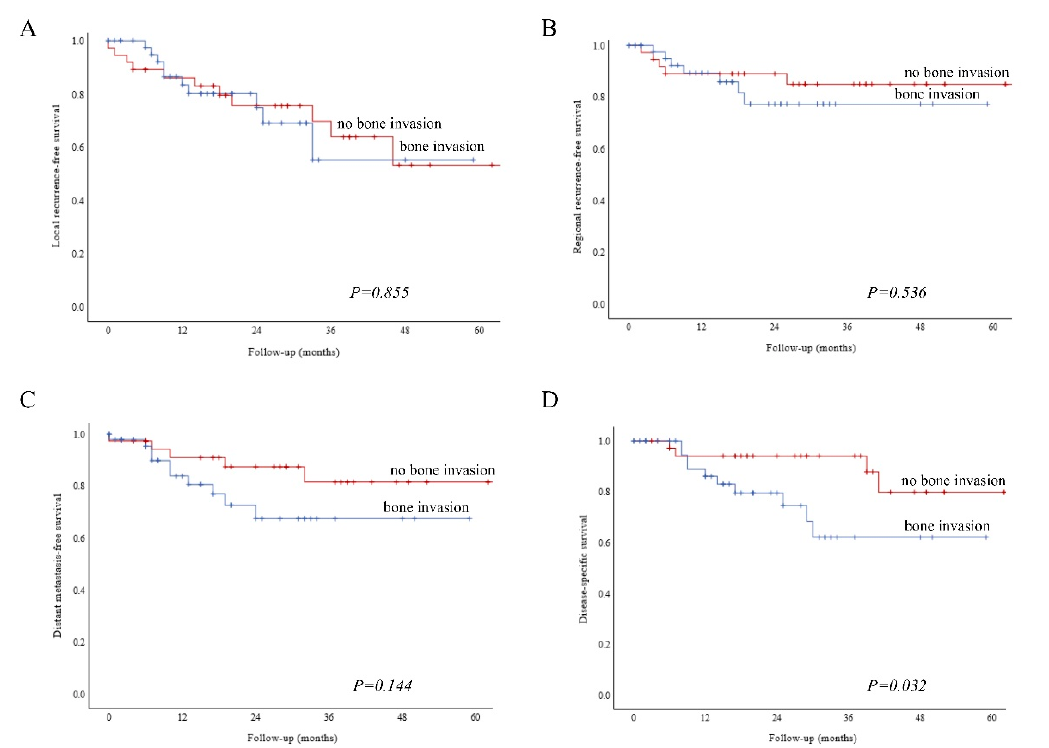
Figure 4. Kaplan–Meier analysis showing relative survival according to bone invasion. Local recurrence-free survival ( A , log-rank, p = 0.855), regional recurrence-free survival ( B , log-rank p = 0.536), and distant metastasis-free survival. ( C , log-rank, p = 0.144) were similar for both groups. Disease-specific survival was worse in patients with bone invasion ( D , log-rank, p = 0.032).